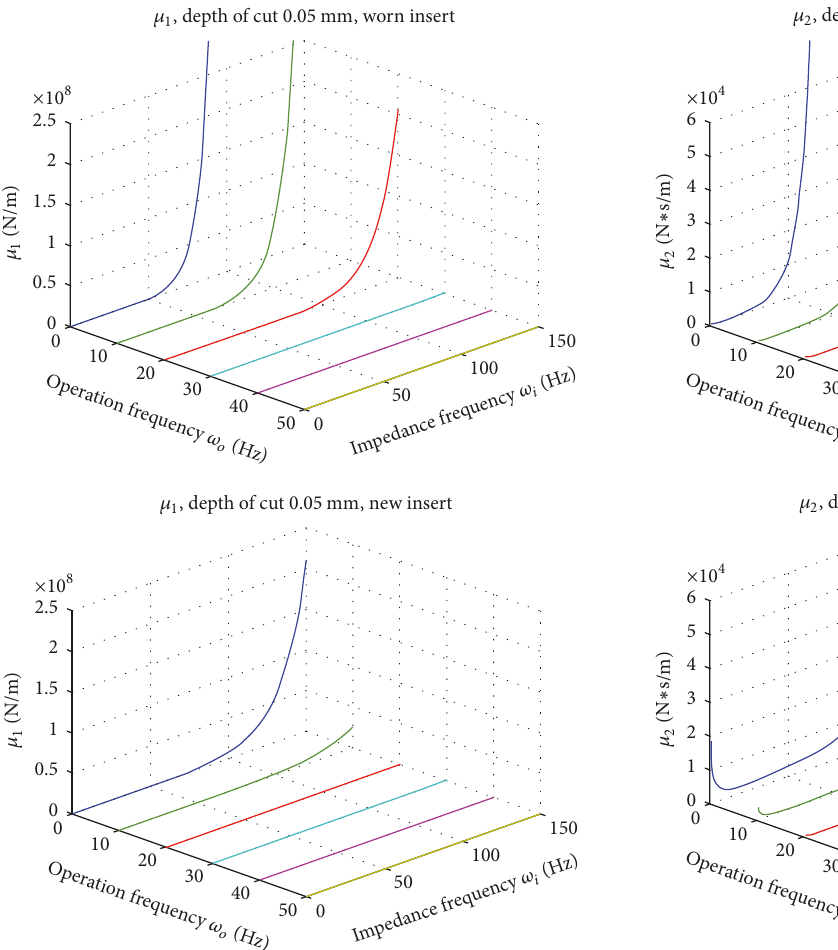
Figure9:Comparisonof 𝜇 1,at0.05mmofdepthofcut,wornversus new insert.